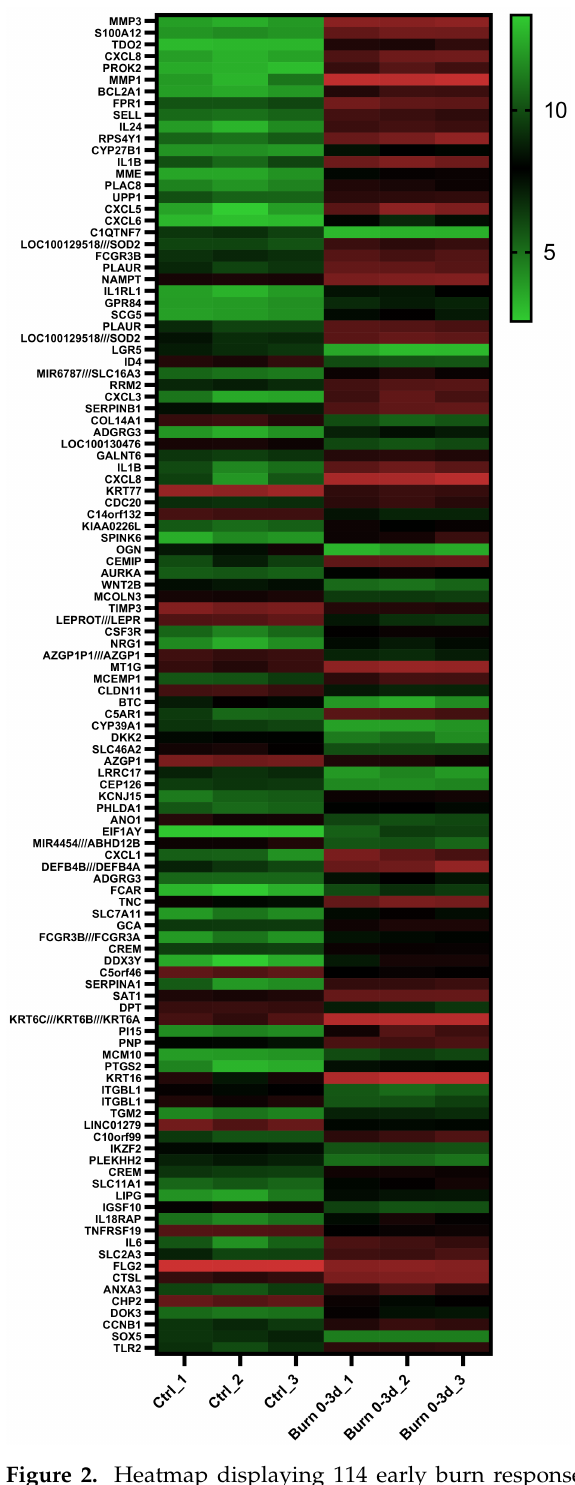
Figure 2. Heatmap displaying 114 early burn response genes that are differentially expressed in the GSE8056 dataset with p adj < 0.001. The color indicates the expression, with green being downregulated and red upregulated. Data are displayed as log2 of normalized